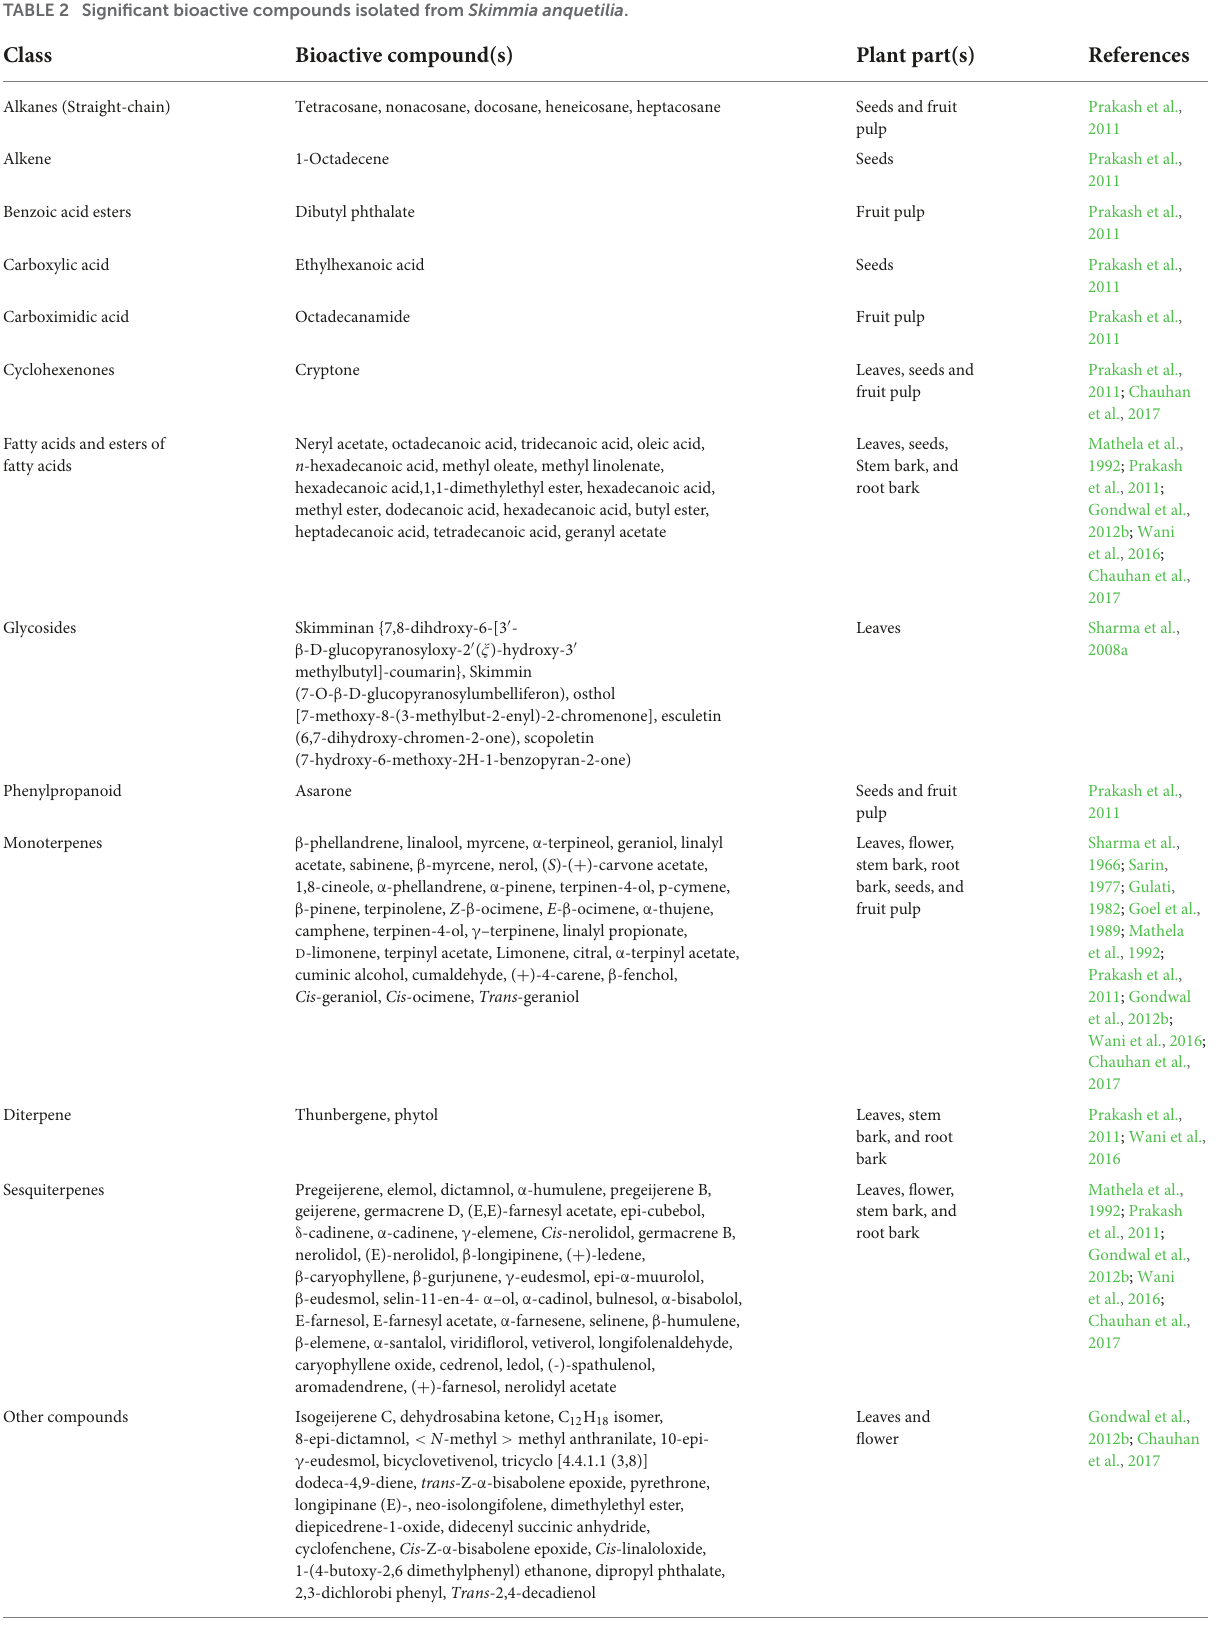
TABLE 2 Significant bioactive compounds isolated from Skimmia anquetilia